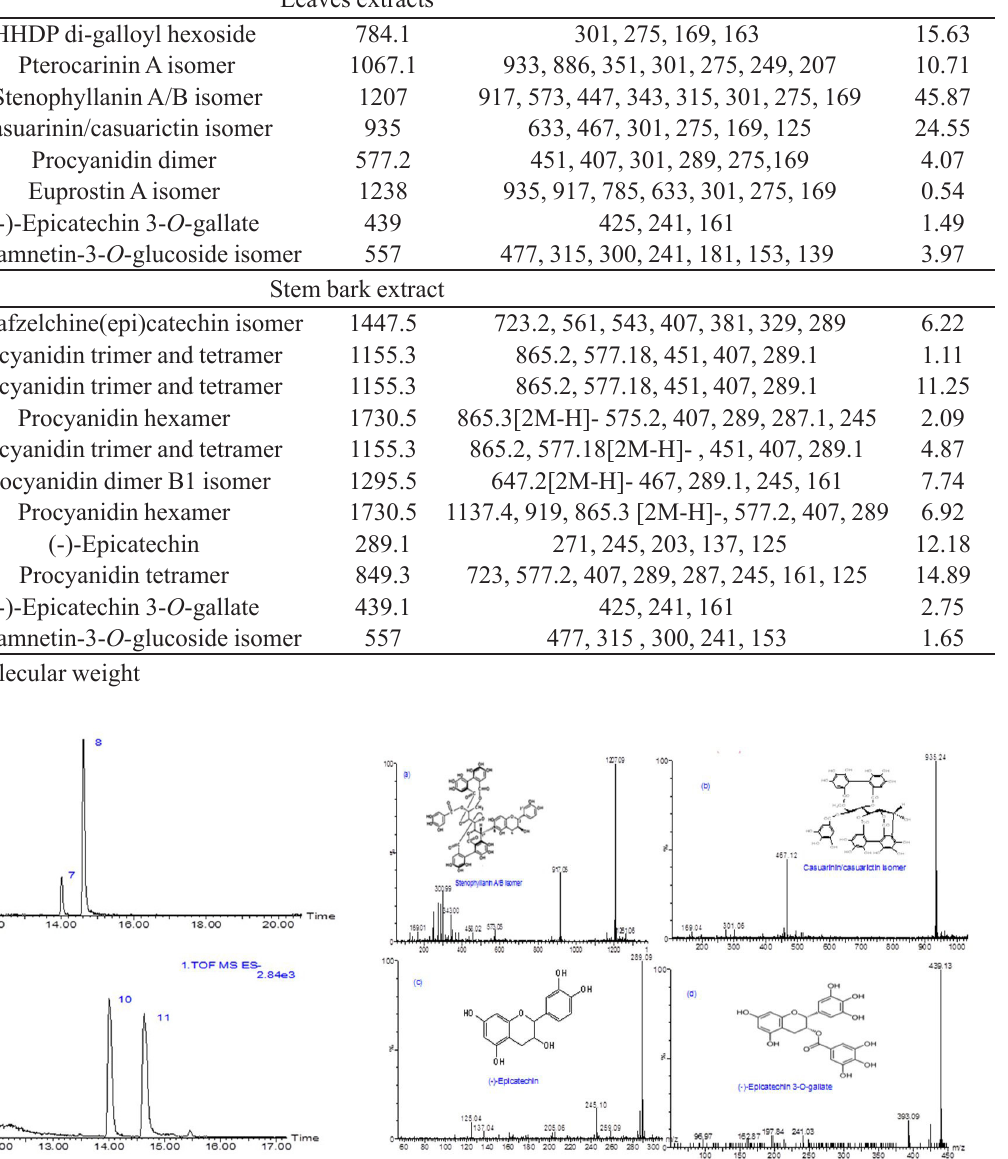
TABLE VI - Detected Compounds in methanol extract of A. laurina leaves and stem No